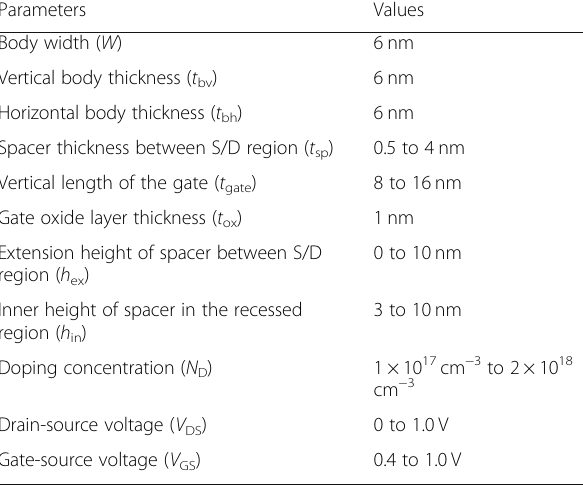
Table 1 Parameter selection for RGUC FET in TCAD simulation